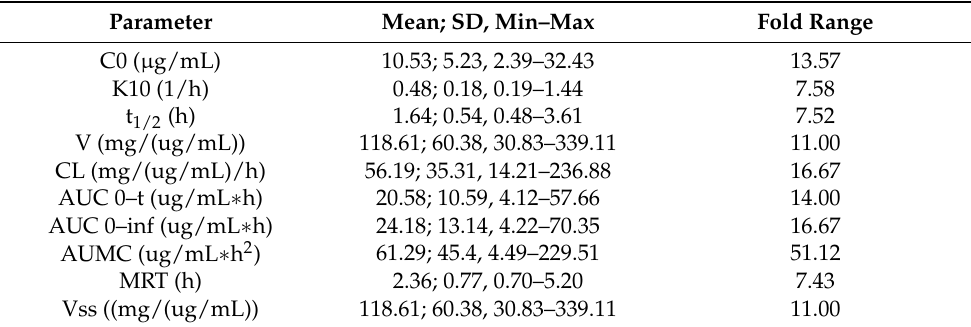
Table 2. Acetaminophen pharmacokinetics in the whole study group.